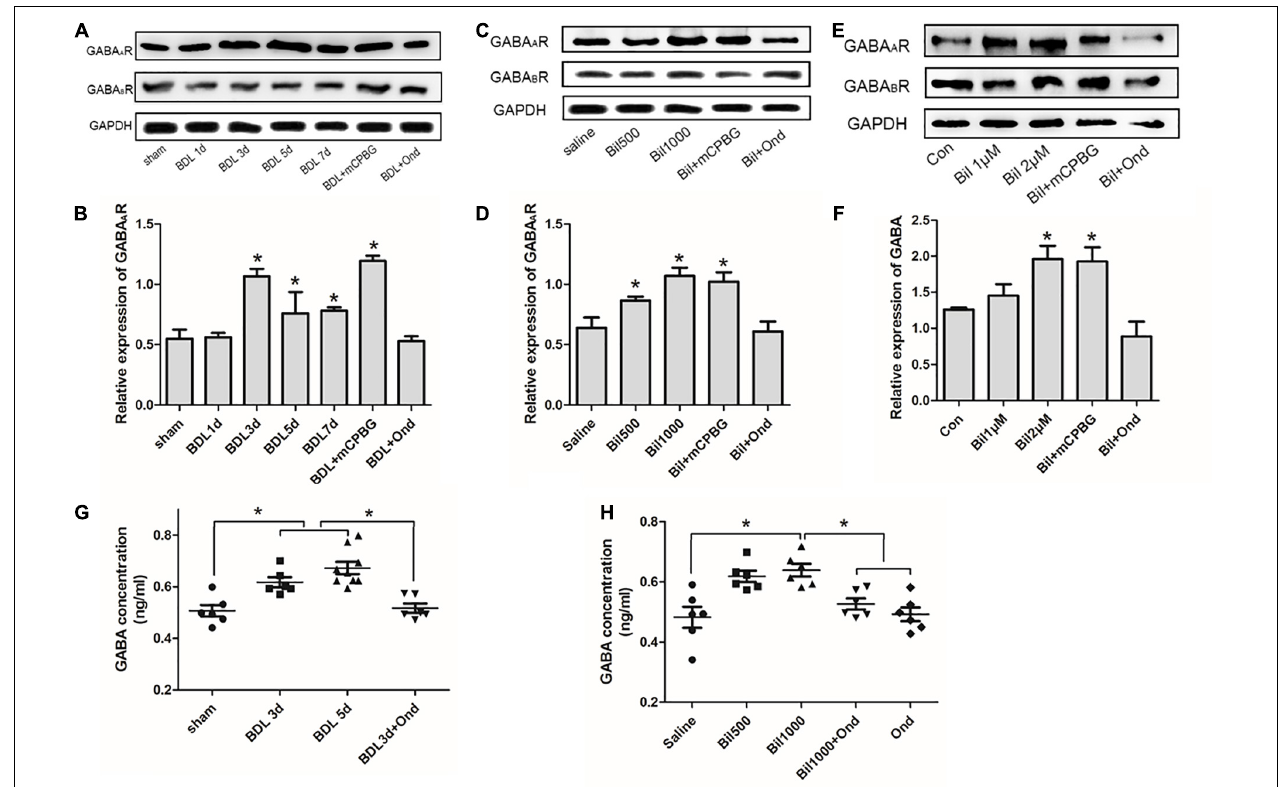
FIGURE 6 | Bilirubin increased GABA A receptor expression, GABA concentration, and GABAergic sIPSC in spinal cords. (A) GABA A receptor expression increased gradually in the spinal cord enlargement of BDL rats without changing GABA B receptor expression, and ondansetron reduced GABA A receptor expression. (B) The quantitative analysis of GABA A receptor expression in the BDL rats. (C) Intrathecal administration of bilirubin increased GABA A receptor expression, and co-administration of bilirubin and ondansetron decreased it without changing GABA B receptor expression. (D) The quantitative analysis of GABA A receptor expression after intrathecal administration of bilirubin in normal rats. (E) SDHNs cultured with bilirubin showed increased GABA A receptor expression without changing GABA B receptor expression, ondansetron reversed GABA A receptor expression. (F) The quantitative analysis of GABA A receptor expression in SDHNs. (G) GABA concentration in CSF of BDL group was significantly higher than sham group, and ondansetron intervention reversed this change. (H) Intrathecal administration of bilirubin (1000 µ M) increased GABA concentration in CSF significantly, whereas ondansetron could reverse it. * P < 0.05.